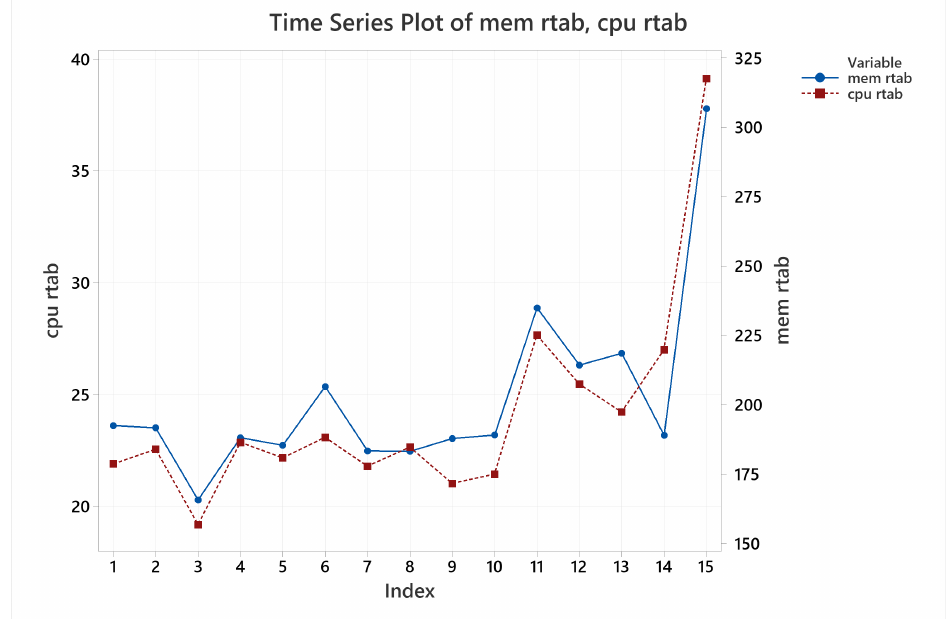
Figure 28. CPU and memory usage means behavior for